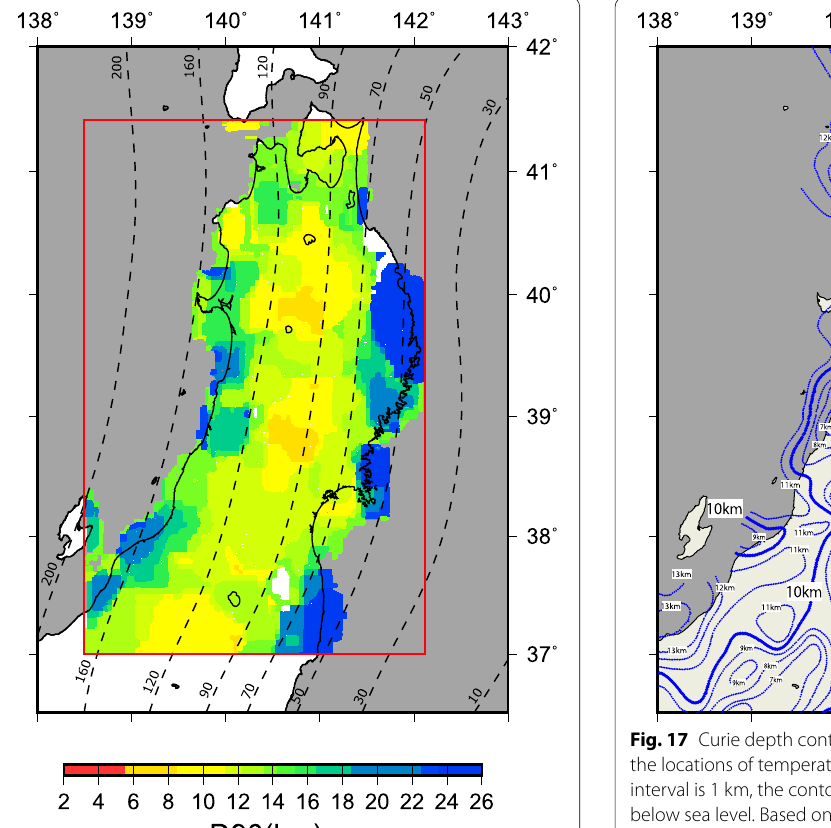
Fig. 16 The spatial distribution of D90, the cut-off depth of shallow seismicity in Northeastern Japan. D90 is the depth above which 90% of the earthquakes occur. The D90 distribution for the area enclosed by the red line is based on Omuralieva et al, (2012). The dotted lines denote depth (km) contours to the top of the subducted Pacific plate (PAC) slab (Iwasaki et al. 2015; Lindquist et al. 2004)